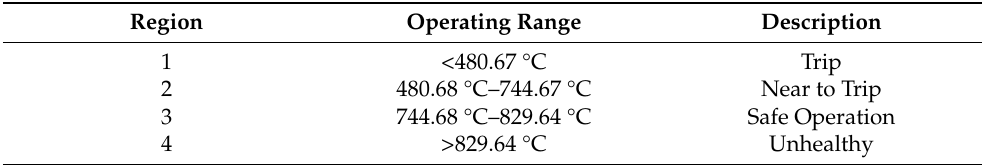
Table 5. Finalized operating range of the DLE gas